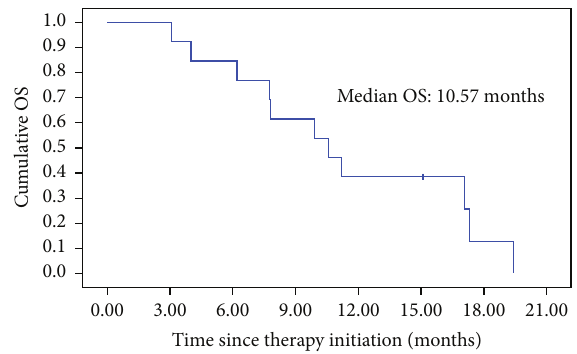
Figure 5: Overall survival measured using the Kaplan-Meier method. The median survival time after first R-CIK cells infusion was 10.57 months. One-year survival rate was